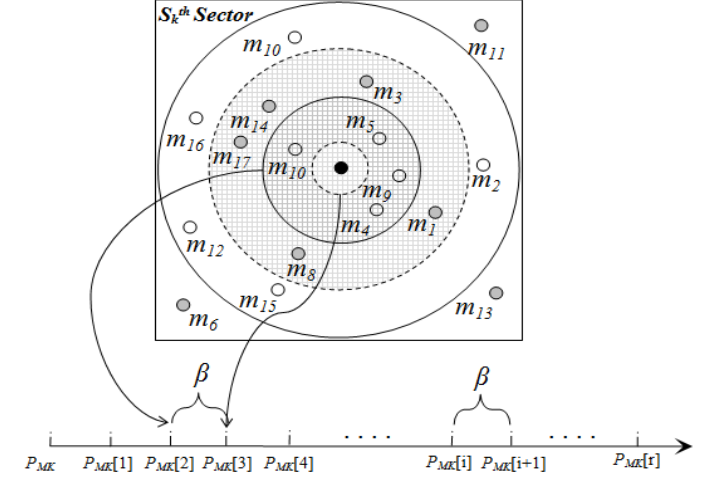
Figure 9. The KNN ( q , 9)—nearest neighbor nodes containing similar data to q inside Sth sector are m 1 , m 3 , m 14 , m 17 , m 8 , m 10 , m 4 , m 9 , m 5 . Range Query